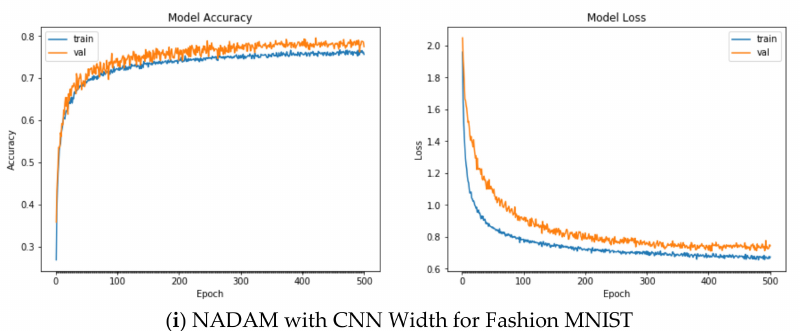
Figure A6. Plots of Train and Validation Test accuracies and losses of the CNN model with varying width for Fashion MNIST: ( a ) Vanilla SGD; ( b ) SGD momentum; ( c ) SGD Nesterov momentum; ( d ) ADAGrad; ( e ) RSMProp; ( f ) ADAM; ( g ) ADADelta; ( h ) ADAMax; ( i ) NADAM.